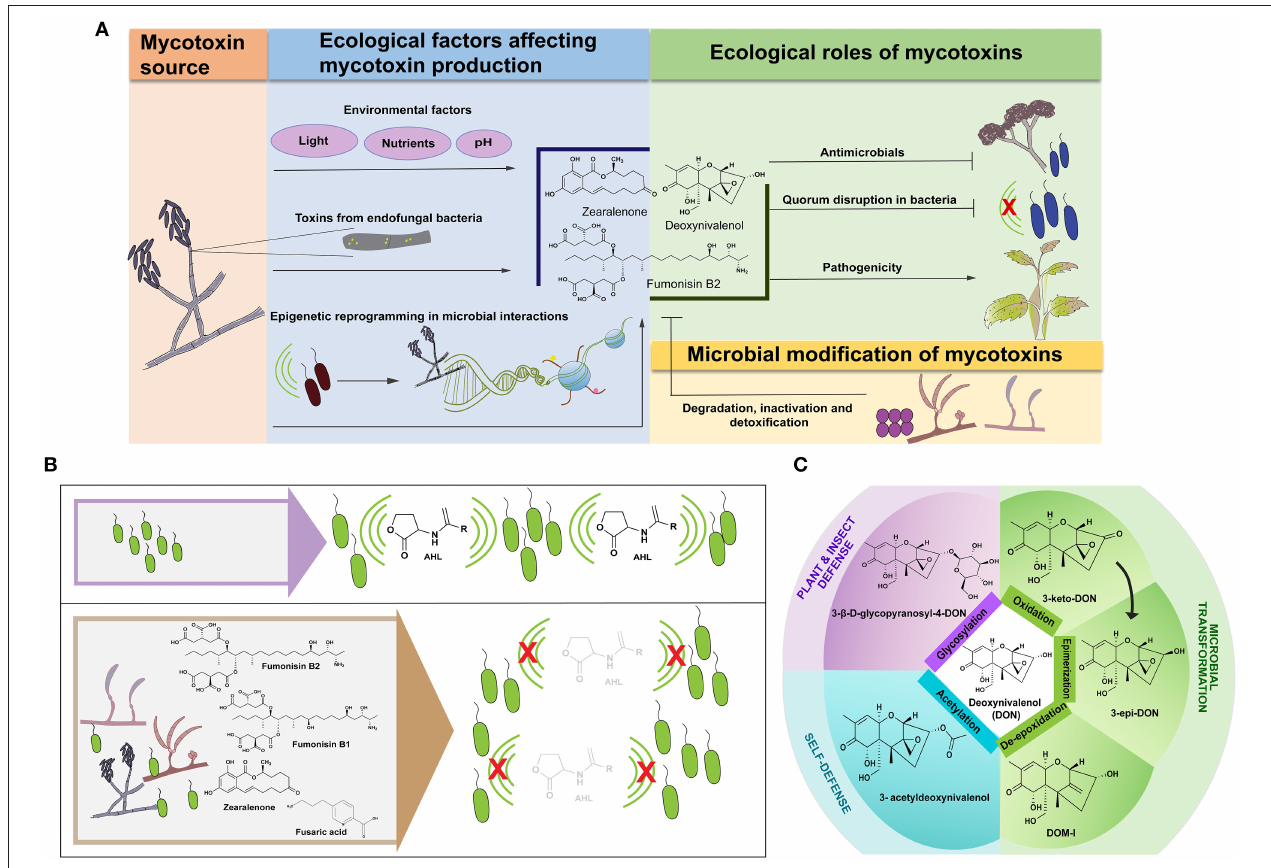
FIGURE 1 | Mycotoxins in microbial interactions. (A) Mycotoxins in the ecological landscape—Bacterial-fungal interactions influence mycotoxin production in addition to environmental factors (blue box). In some cases, the toxin may be produced by an endofungal bacterium (shown as yellow circular bacteria residing in the gray hypha). Microbial interactions may alter epigenetic modifications (indicated by DNA wrapped around blue histones where the yellow and pink shapes represent epigenetic modifications in the histone tail) that regulate mycotoxin production. These secreted mycotoxins in turn play vital roles in shaping ecological niches (green box) by acting as antimicrobials in addition to inhibiting bacterial quorum-based communication (bacterial communication is represented with green arcs; the red “X” indicates disruption of communication). Mycotoxins also alter the pathogenic abilities of the producing fungus that in turn may influence the microbial communities in the niche. In such niches, microbes (represented by fungi and spherical bacteria in the yellow box) can detoxify, degrade, and inactivate mycotoxins. (B) Fusarium mycotoxins inhibit acyl homoserine lactone (AHL)-based quorum sensing in bacteria. (Top panel) The green arcs indicate active quorum-based communication in a bacterial population. (Bottom panel) The left end of the lower box shows Fusarium spp. co-occurring with bacteria. The right end shows mycotoxins produced by Fusarium spp. that contribute to quorum quenching in the bacterial population, indicated by the red “X” over the green arcs. (C) Detoxification processes of deoxynivalenol (DON) and their products that have been tested to show reduced toxicity compared to DON. The arrow from 3-keto-DON to 3-epi-DON indicates that formation of the epimer proceeds with 3-keto-DON as an